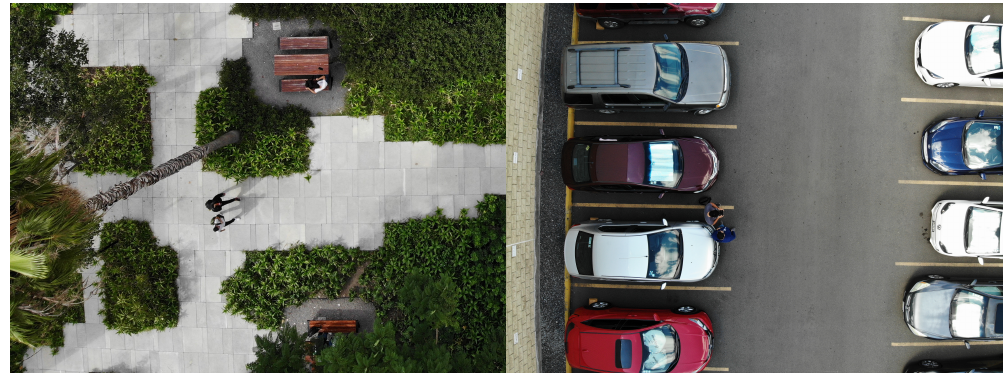
Figure 1. Pictures taken by a Drone looking down to the